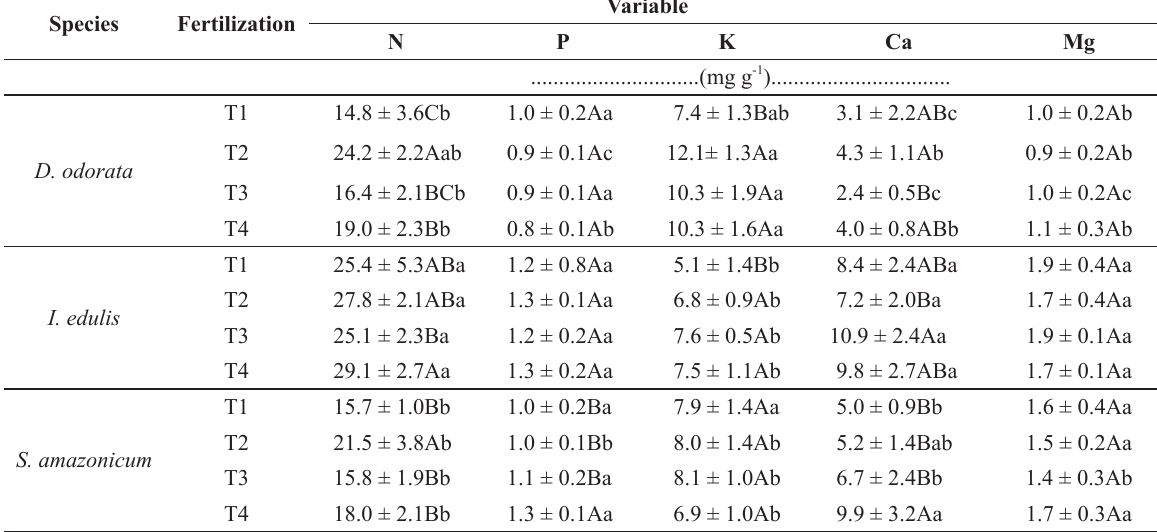
Leaf nutrient contents of the three tested species under the different fertilization treatments in a forest restoration plantation in an area degraded by the Balbina Hydroelectric Dam, AM - Brazil. T1 – no fertilization, T2 – chemical fertilization; T3 – organic fertilization, and T4 – organic and chemical fertilization.